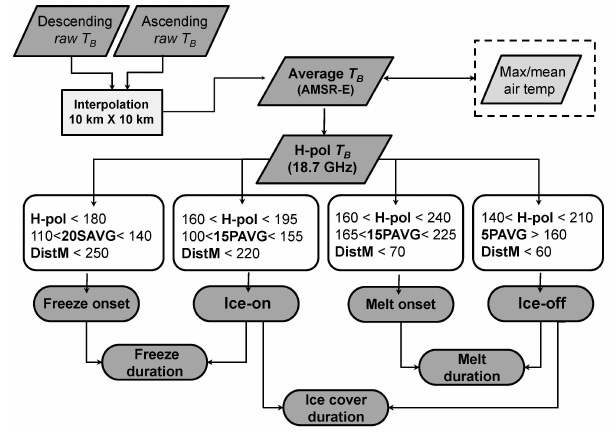
Fig. 3. Flowchart of ice phenology algorithm based on AMSR- E 18.7 GHz horizontal polarization (H-pol) brightness temperature ( T B ) . All threshold values are explained in Sect.